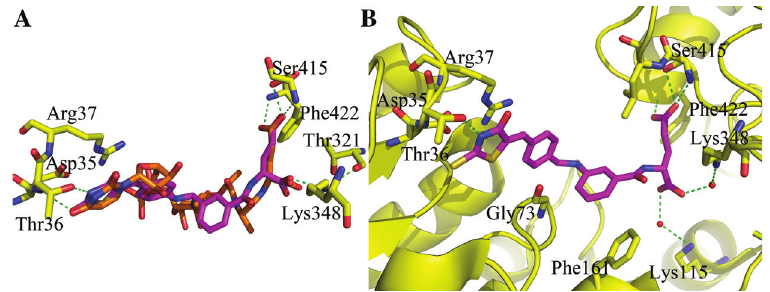
Figure 3 Binding modes of 5-benzylidenethiazolidin-2,4-dione and 5-benzylidenerhodanine inhibitors.